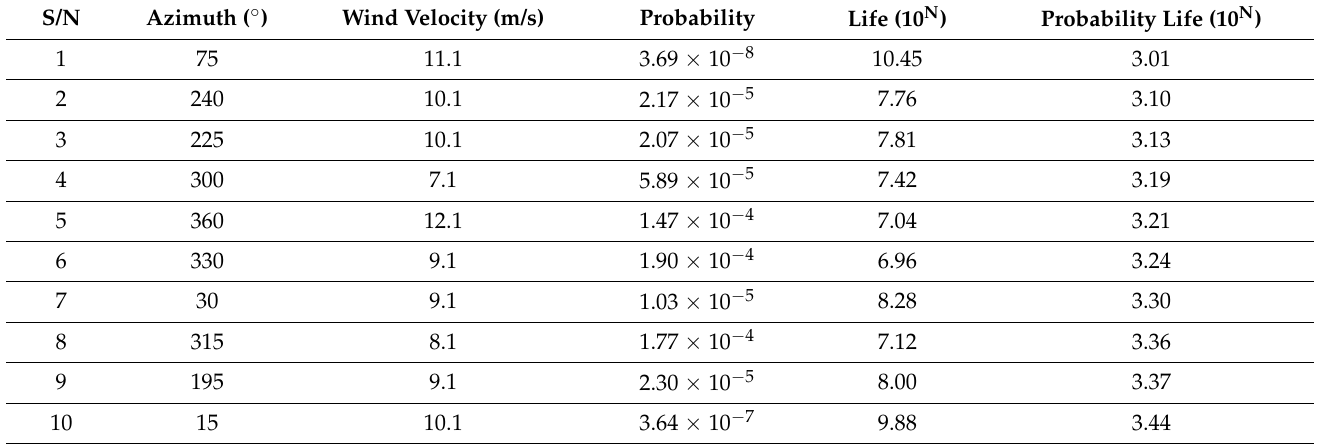
Table 8. Some working conditions with shorter probability life of node 4 in northwest